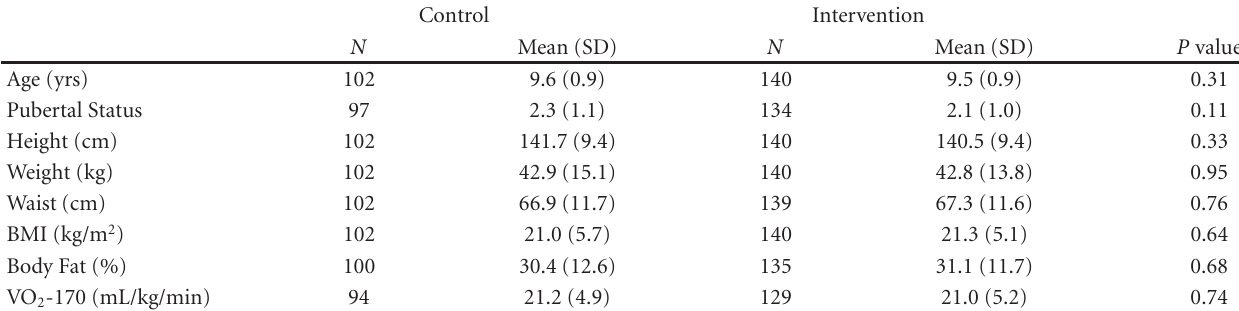
Table 1: Baseline subject characteristics.